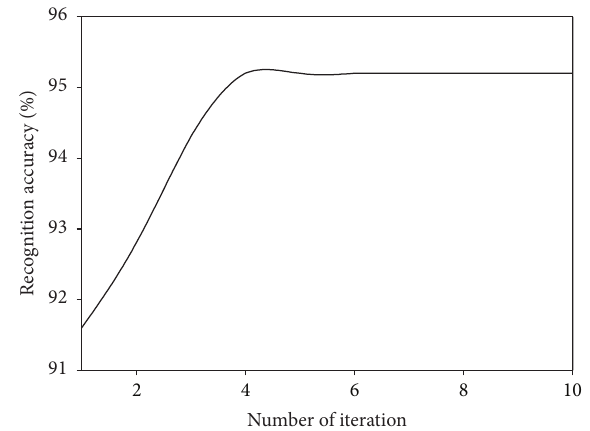
Figure 11: Recognition accuracy of MDGPP versus varying param- eter 𝜆 on the CMU PIE database.